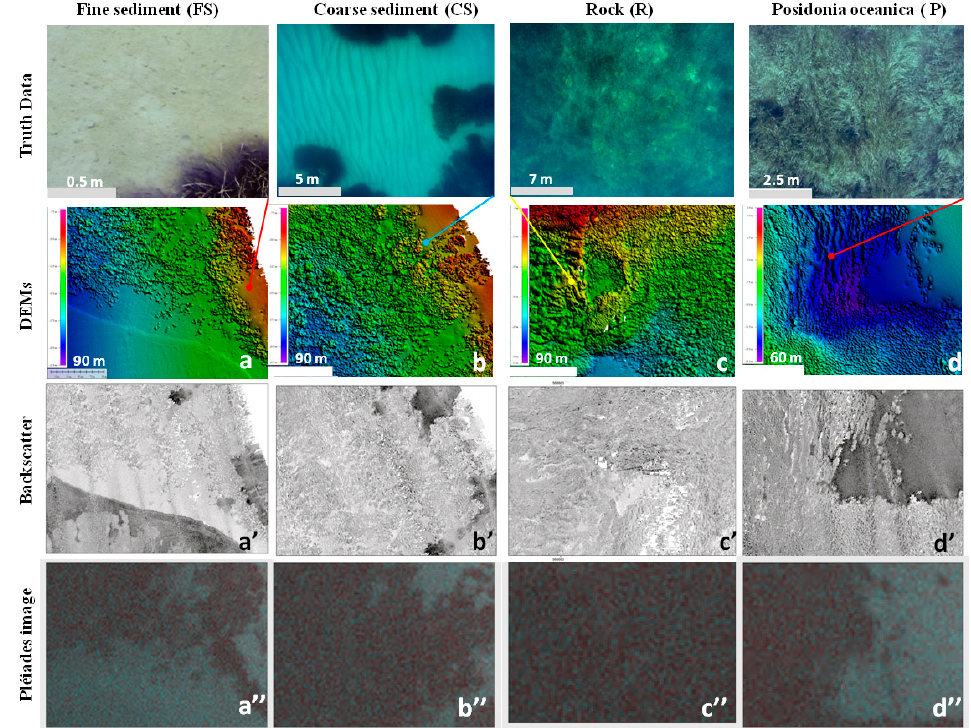
Figure 13. Comparison between seafloor mapping techniques using optical GoPro images collected by (UTCS) and Autonomous Surface Vehicle (DEVSS) and: ( a , b , c , d ) high-resolution multibeam bathymetry, ( a’ , b’ , c’ , d’ ) backscatter intensity data, ( a’’ , b’’ , c’’ , d’’ ) multispectral reflectance of Pléiades images. The data collected in the study area show different types of seafloor: sediments (from fine to coarse), rocks and P. oceanica . The GoPro images were used to interpret and calibrate the morphological features while using the eCognition software. See Figure 14 for location.